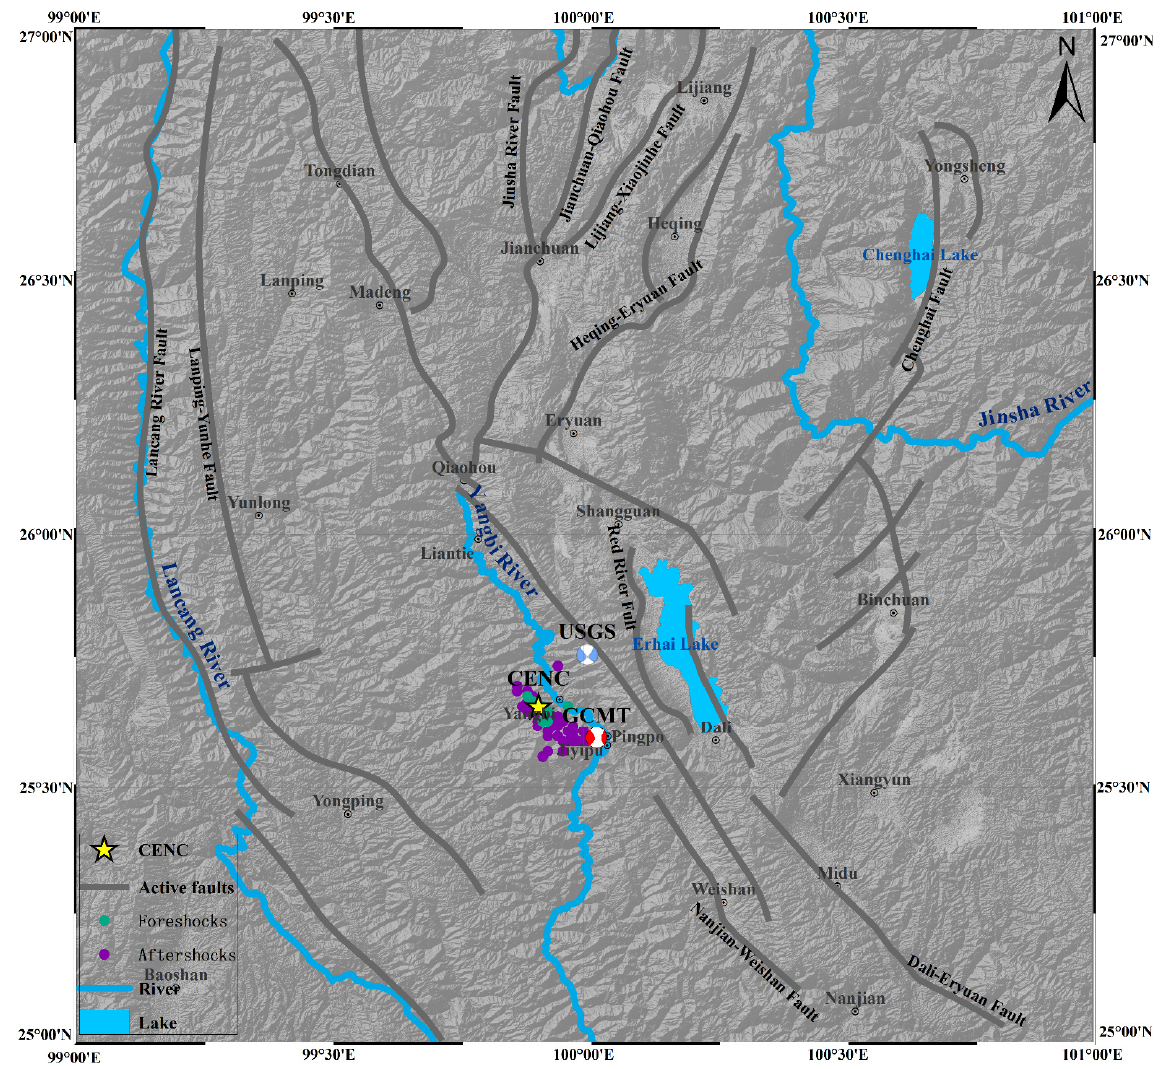
Figure 1. Regional tectonic background of Yangbi and the surrounding areas. The red and blue beach balls represent the focal mechanisms of the 2021 Yangbi M W 6.1 earthquake provided by the Global Centroid Moment Tensor (GCMT) and the United States Geological Survey (USGS), respectively; the gray lines denote the major active faults in this area; the yellow star is the epicenter provided by the China Earthquake Networks Center (CENC); the green dots and the purple dots indicate foreshocks and aftershocks,